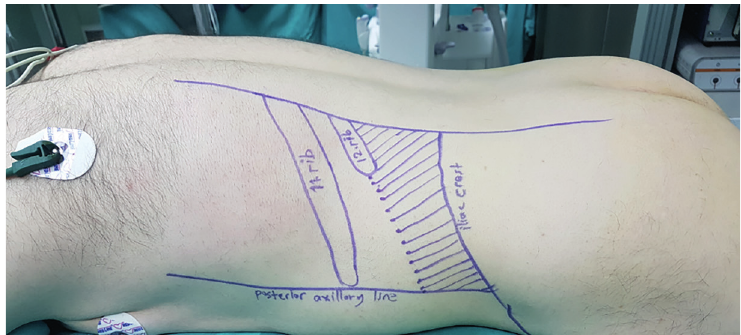
Figure 2 - Prone position. The shaded area between lower rib margin, posterior axillary line and iliac crest shows the subcostal access location in prone